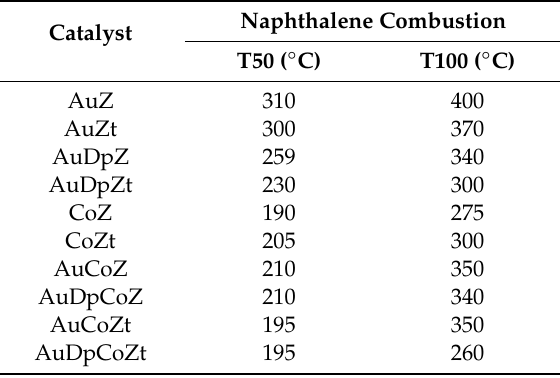
Table 6. T50 and T100 obtained with catalysts in naphthalene